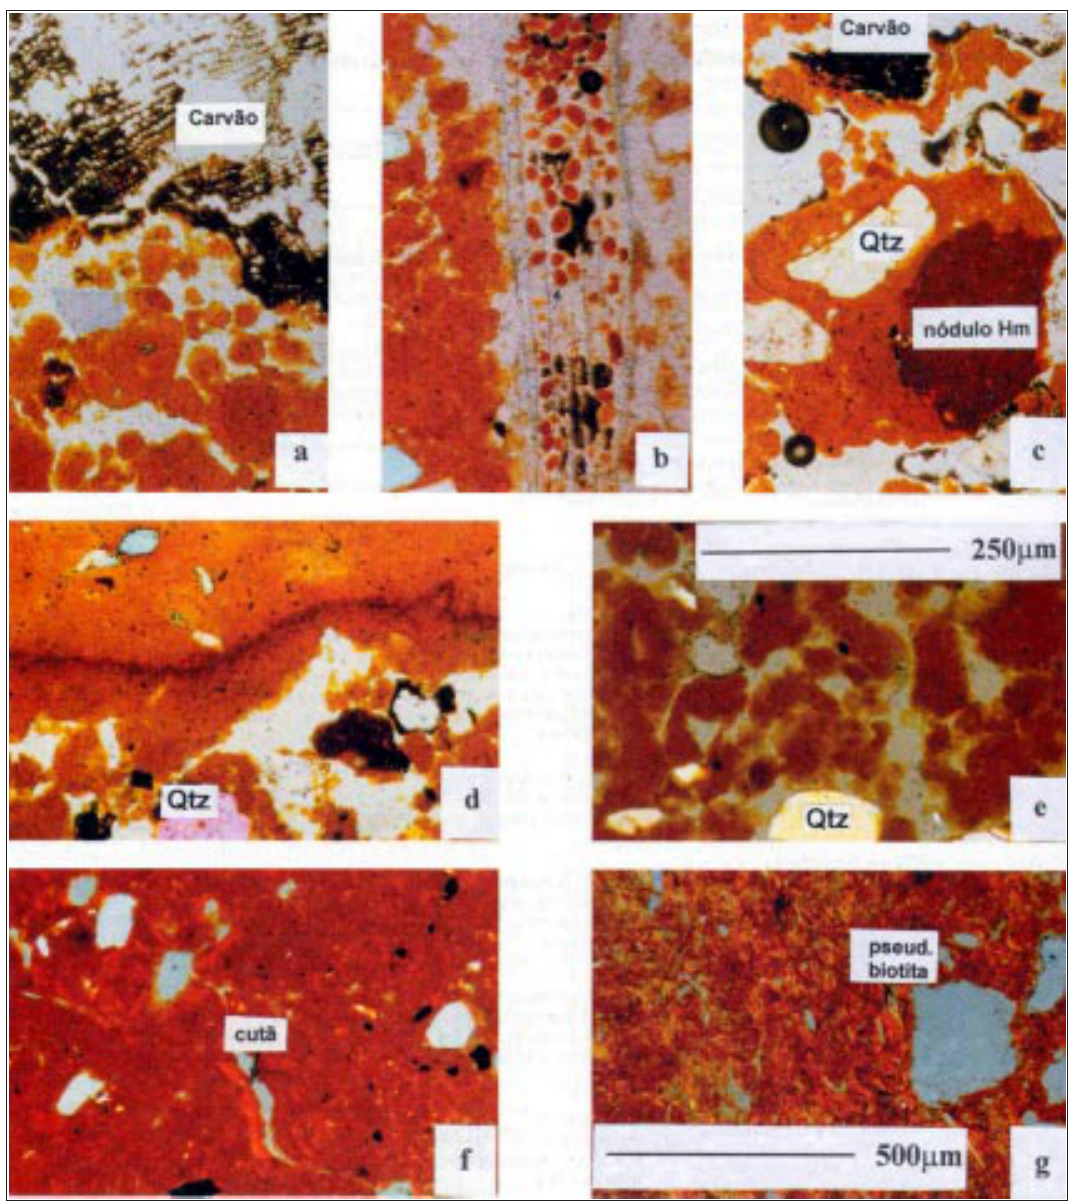
Figura 2. Fotomicrografias dos horizontes estudados do Latossolo Una: AB (a, b, c, d), Bw2 (e), BC1 (f) e BC2 (g). As fotomicrografias a-e obedecem à barra de escala de 250 mm; f-g com barra de 500